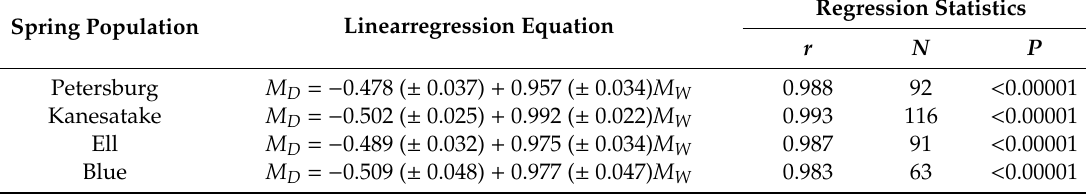
Table A1. Log 10 dry body mass ( M D ) as a function of log 10 wet dry mass ( M W ) (measured as mg) in four spring-dwelling populations of Gammarus minus . Least squares regression equations are shown with 95% confidence intervals for the intercept and slope in parentheses. Associated Pearson’s product-moment correlation coe ffi cients ( r ), sample sizes ( N ) and levels of significance ( P ) are also given. Body masses were measured in amphipods used in the growth study (also see [13]). Spring